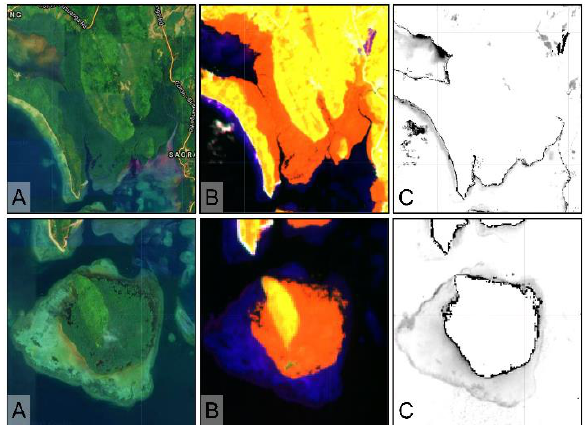
Figure 19 . Contrast visualization of mangroves against other vegetation in (A) Google Earth satellite imagery, (B) FCC, and (C) MVI